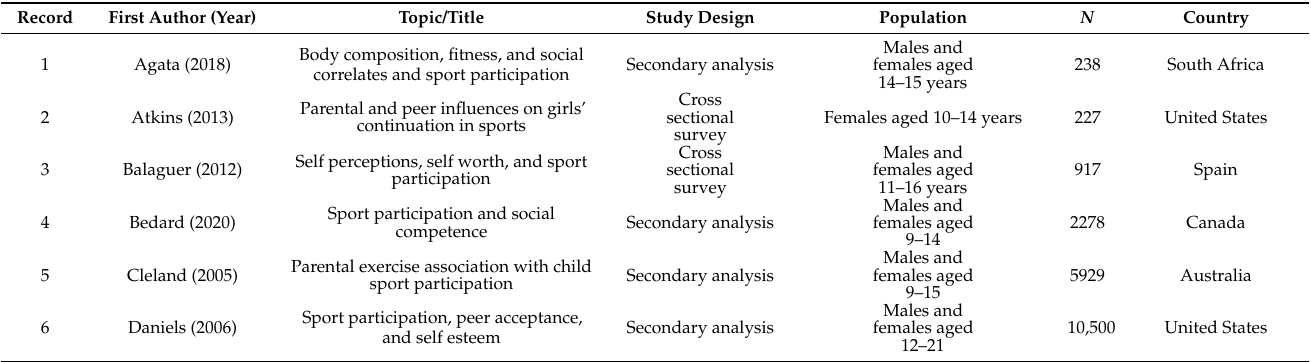
Table 1. Description of study